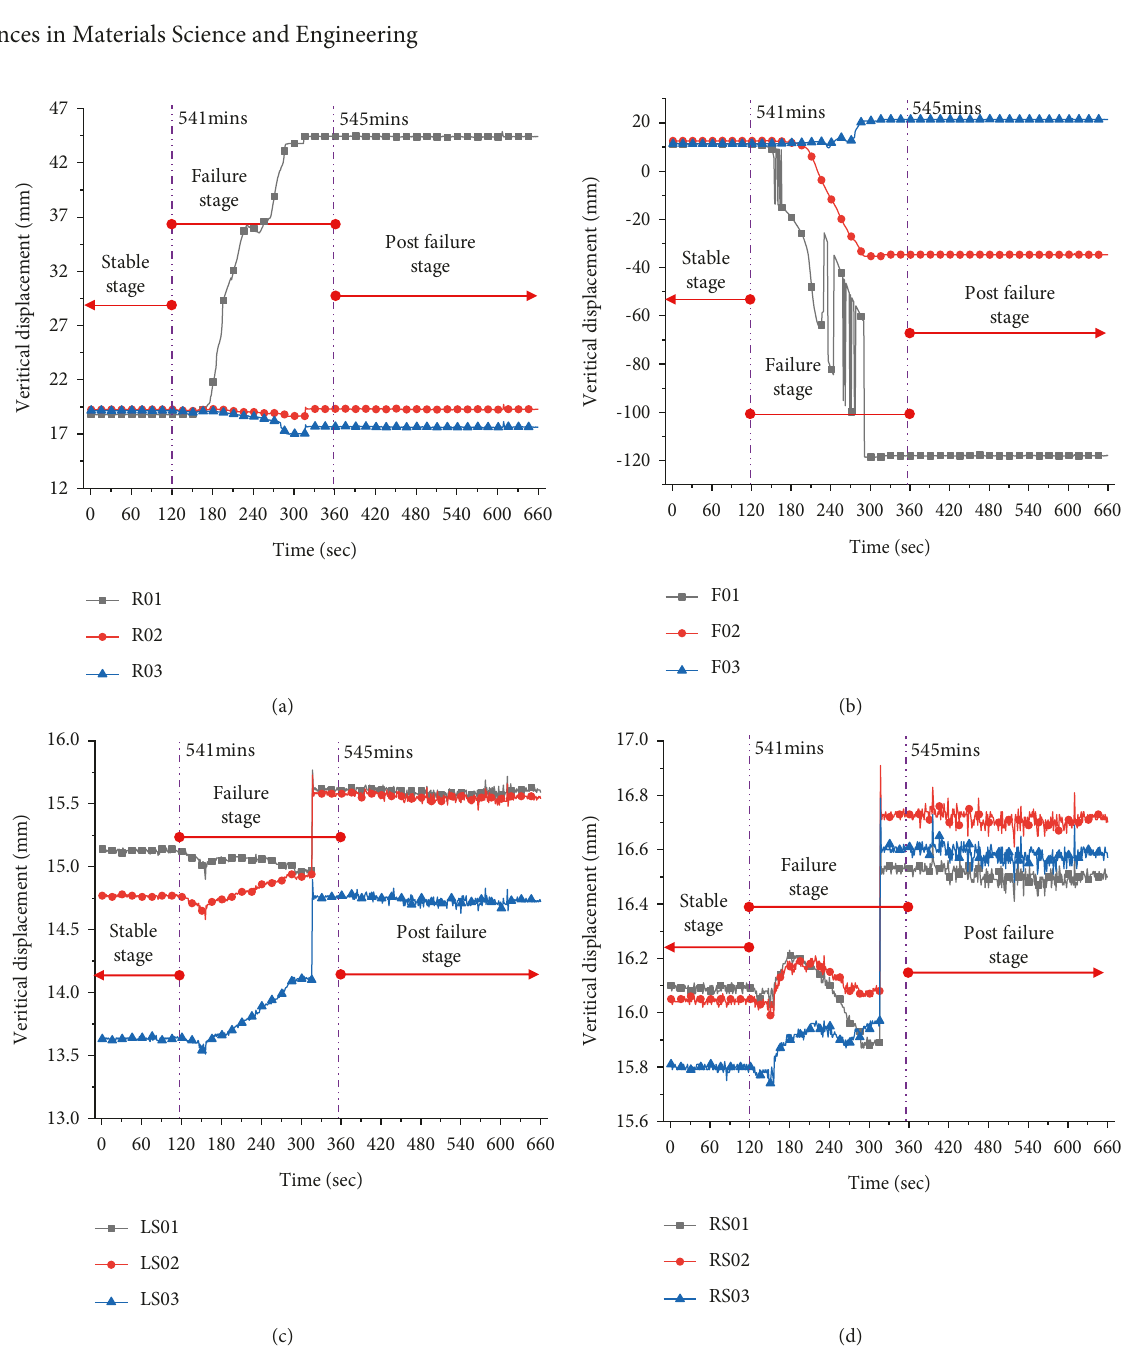
Figure 7: Vertical displacement of measuring points when the cumulative duration is 539–550mins; (a) R01, R02, and R03; (b) F01, F02, and F03; (c) LS01, LS02, and LS03; and (d) RS01, RS02, and